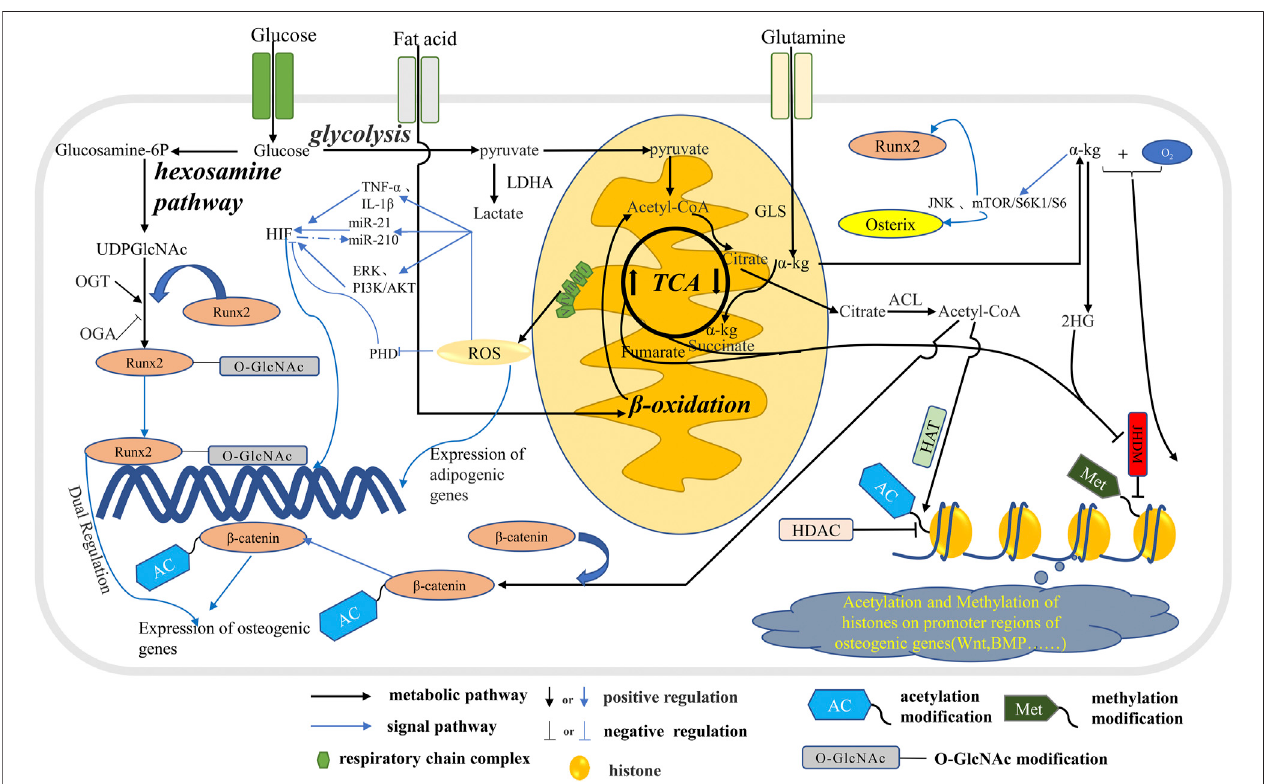
FIGURE 2 | The metabolic pathways in osteoblast affect signal transduction. Glucose, fatty acids and glutamine are metabolized through the tricarboxylic acid cyclein mitochondria toproduce citric acid,whichismetabolized intoacetyl-CoA inthecytoplasm. Partofacetyl-CoA entersthenucleus toparticipateintheacetylation ofhistonesandregulatetheexpressionofrelatedgenes.Aportionofacetyl-CoAparticipatethe ß -cateninacetylationwhichregulatetheexpressionofosteogenicgenes. Glucose produces UDPGlcNAc through the hexosamine pathway, which participates in the O-GlcNA modi fi cation of osteogenic transcription factor Runx2 and regulates the expression of osteogenic genes. In addition, ROS produced during mitochondrial OXPHOS inhibits osteogenesis by stimulating the expression of adipogenic genes. In addition, ROS further in fl uences the energy metabolism phenotype in osteoblasts by regulating HIF through multiple pathways. α -Kg produced by glutamine and TCA cycles promotes osteogenic differentiation by means of histone methylation and JNK and mTOR/S6K1/S6